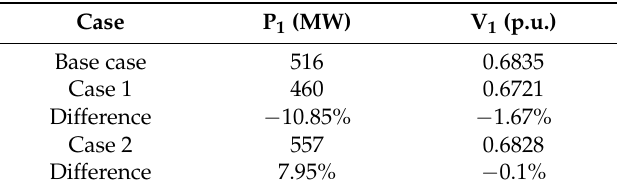
Figure 8. PV (The Voltage and Power) curves of bus 1 for the 6 cases: ( a ) PV curves; ( b ) zoomed in around the critical state. P 1 : the power of bus 1. V 1 : the voltage of bus 1. Table 10. Maximum power transmission under seasonal variation.